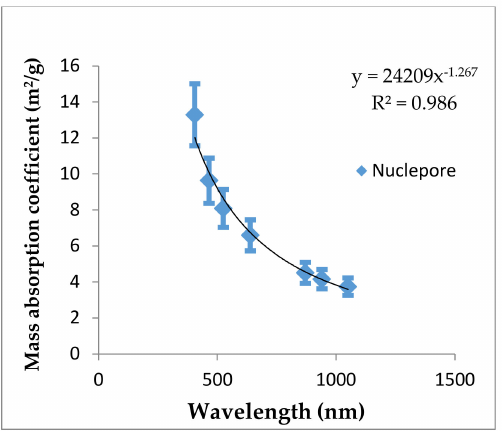
Figure 3. Mass absorption coefficient vs wavelength for nucleopore